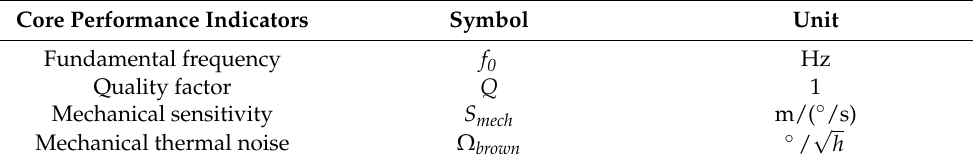
Table 2. The core performance indicators table of the disk MEMS